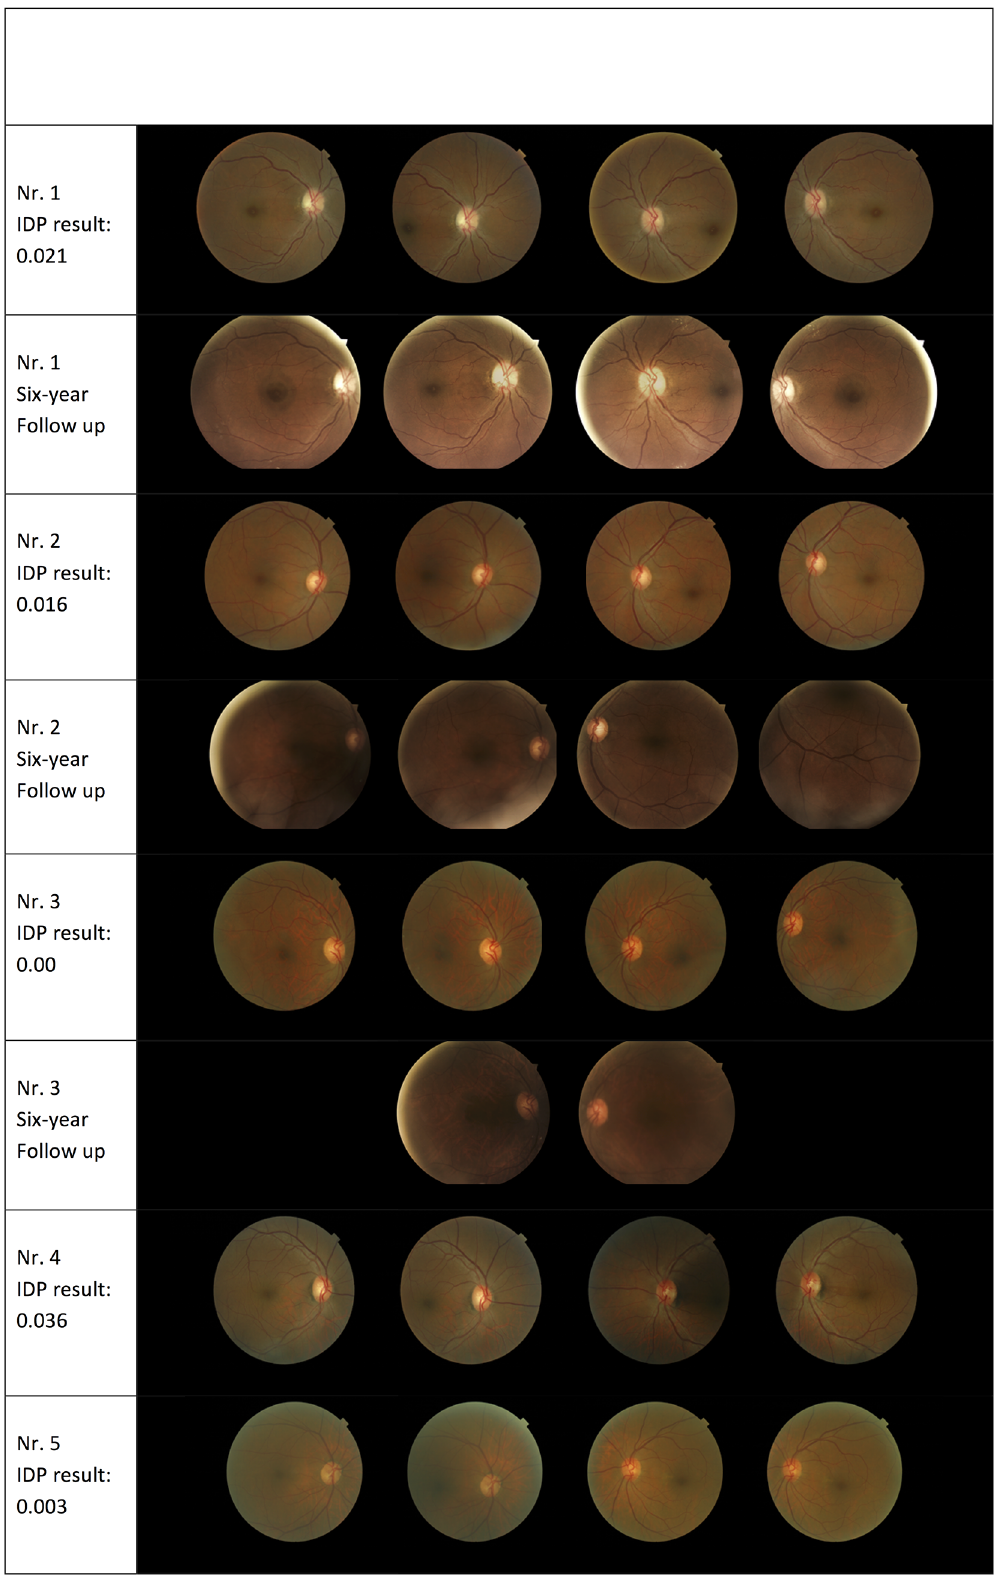
Fig 2. – Five false negative